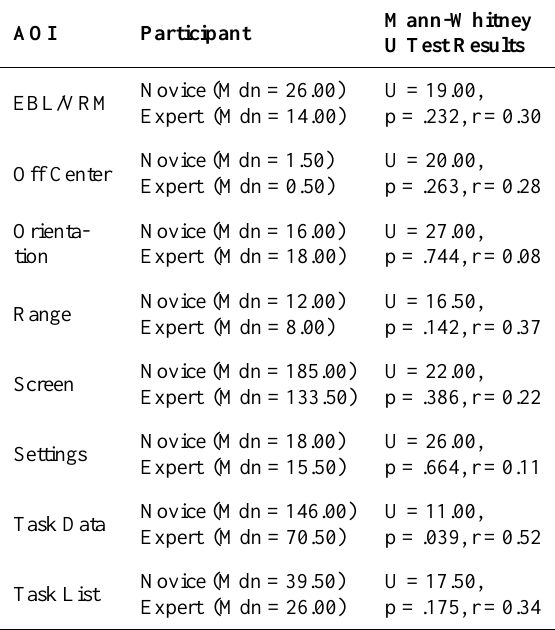
Table 7. Mann-Whitney U Test Results for total fixation counts of novice and expert participants on radar